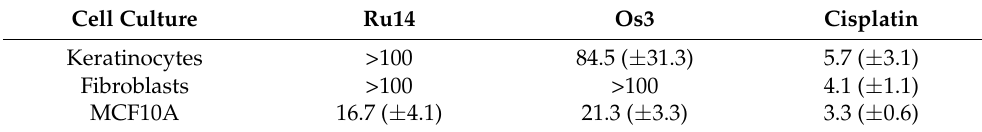
Table 4. IC50 values [ µ M] for non-cancerous cell